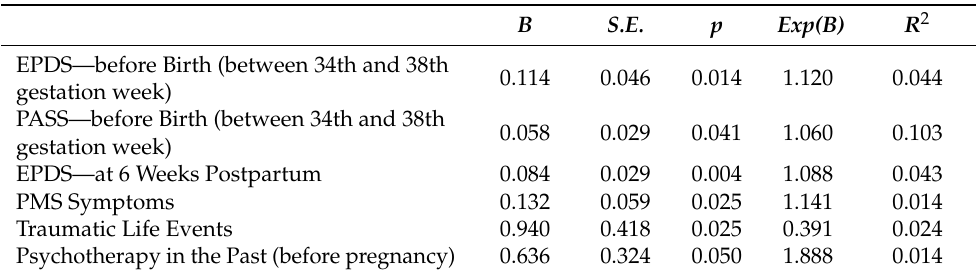
Table 3. Multivariate binary logistic regression analyses for the identification of independent variables that predict lactation